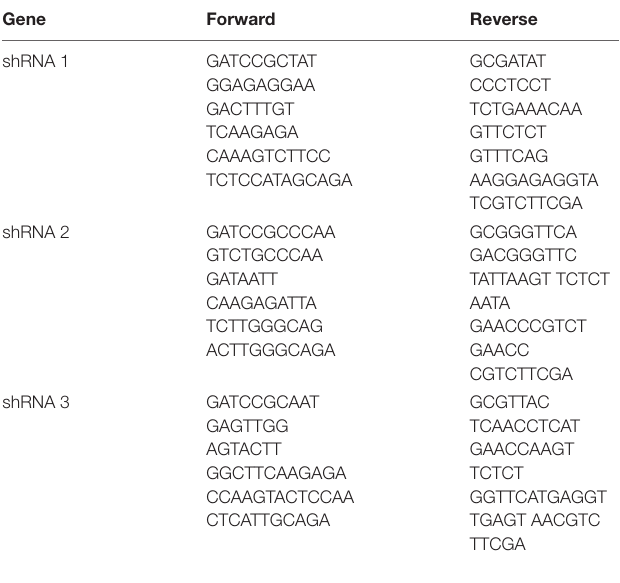
TABLE 2 | Slc4a2 shRNA